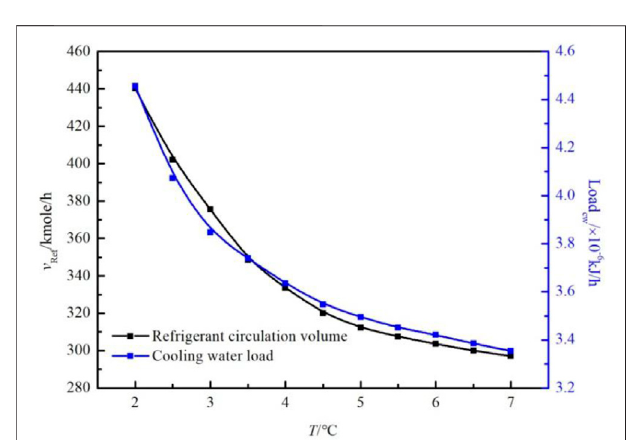
FIGURE 7 | In fl uence of natural gas pressure on power consumption and exergy loss of the system.